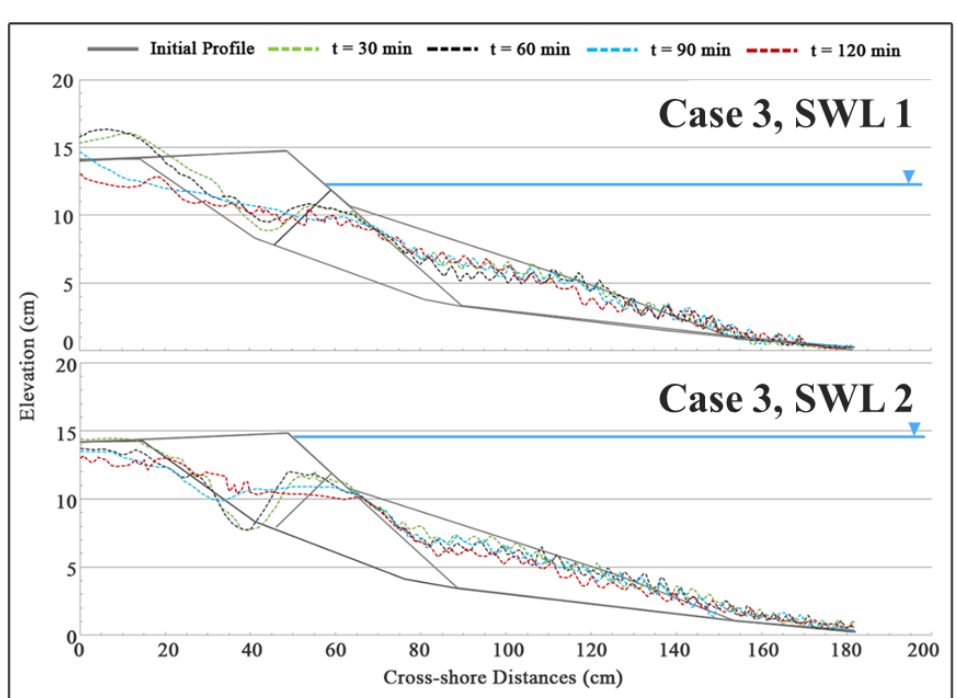
Figure 10. Case 3 with SWL 1 and SWL 2 profile evolution of t 1 , t 2 , t 3 , and t 4 . In test case 3, the gravel inside the berm formed a permeable layer. The gravel layer inside the sand berm acted as a water-permeable filter and, unlike in test case 1 which consisted of only a sand berm, it slowed the erosion rate in the area behind the gravel. This can be seen as a filter for the permeable layer of gravel and it kept the sand inside the rear section unsaturated for a period of time. Having high permeability, the gravel on the beach face caused wave water infiltration before the wave washed back to sea. Thus, the permeability helped to minimize cross-shore sediment transport and the resulting ero- sion. For SWL 2, erosion accelerated. However, when compared to test case 1 with SWL 2, the gravel layer was protected from the scour. In an overall comparison with SWL 1, the landward edge of the gravel layer was eroded after the berm erosion progressed land- ward, and the thin layer of gravel provided some protection for the sand below the gravel layer.